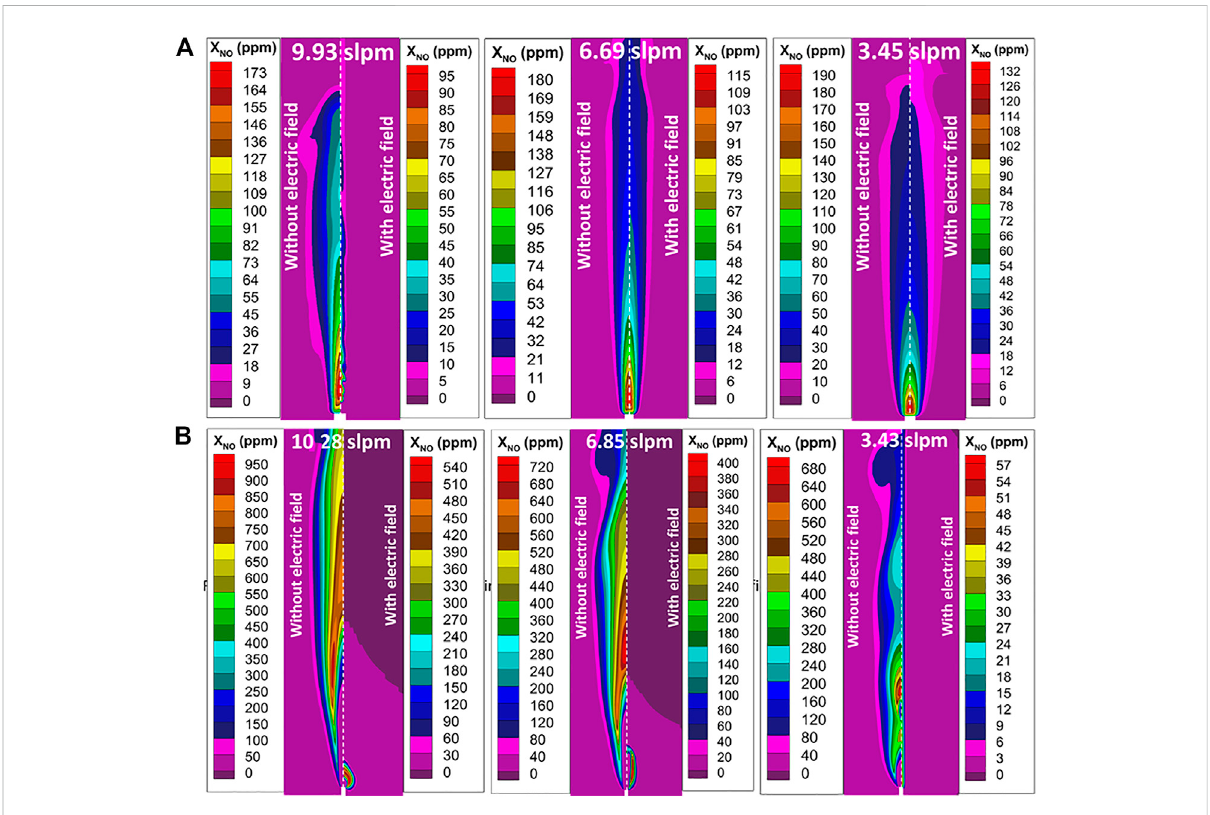
Comparisons of the NO distribution in the domain with and without electric fi eld for premixed CH 4 /air mixture under different fl ow rate conditions and (A) ϕ = 1.0, and (B) ϕ =